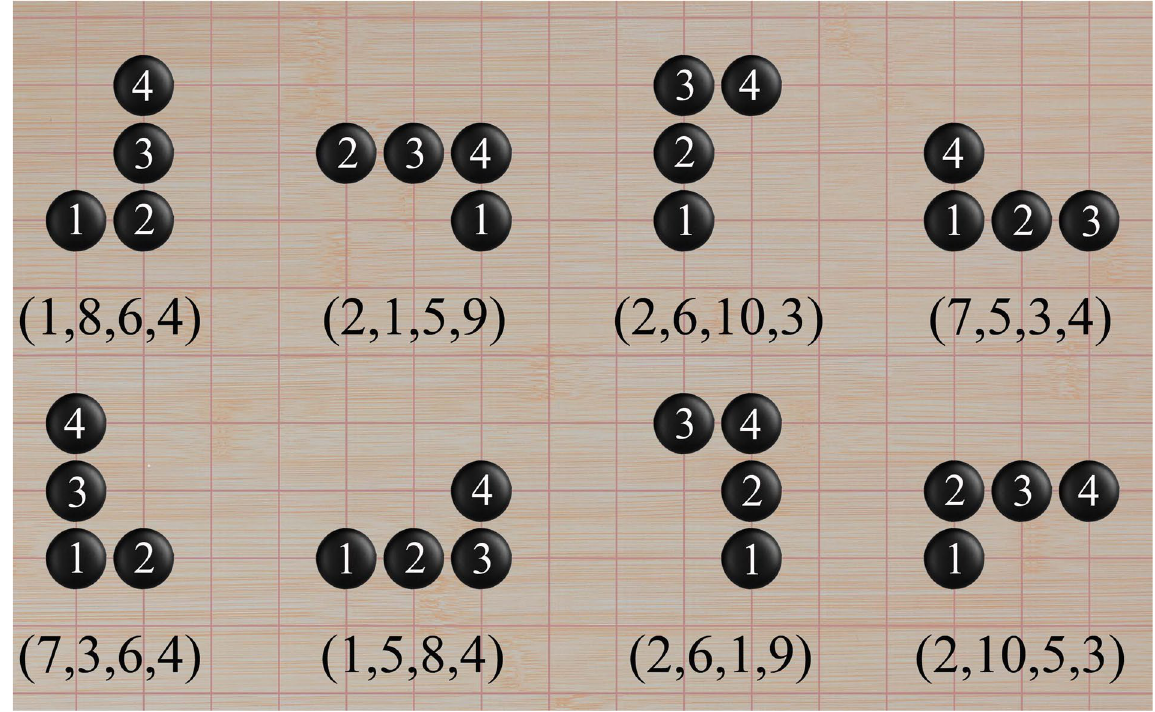
Figure 2. The different orientations of a given structure for 4-atom cluster under the action of group D 4 for square lattice and the corresponding vertex-type sequences. The minimum vertex-type sequence is